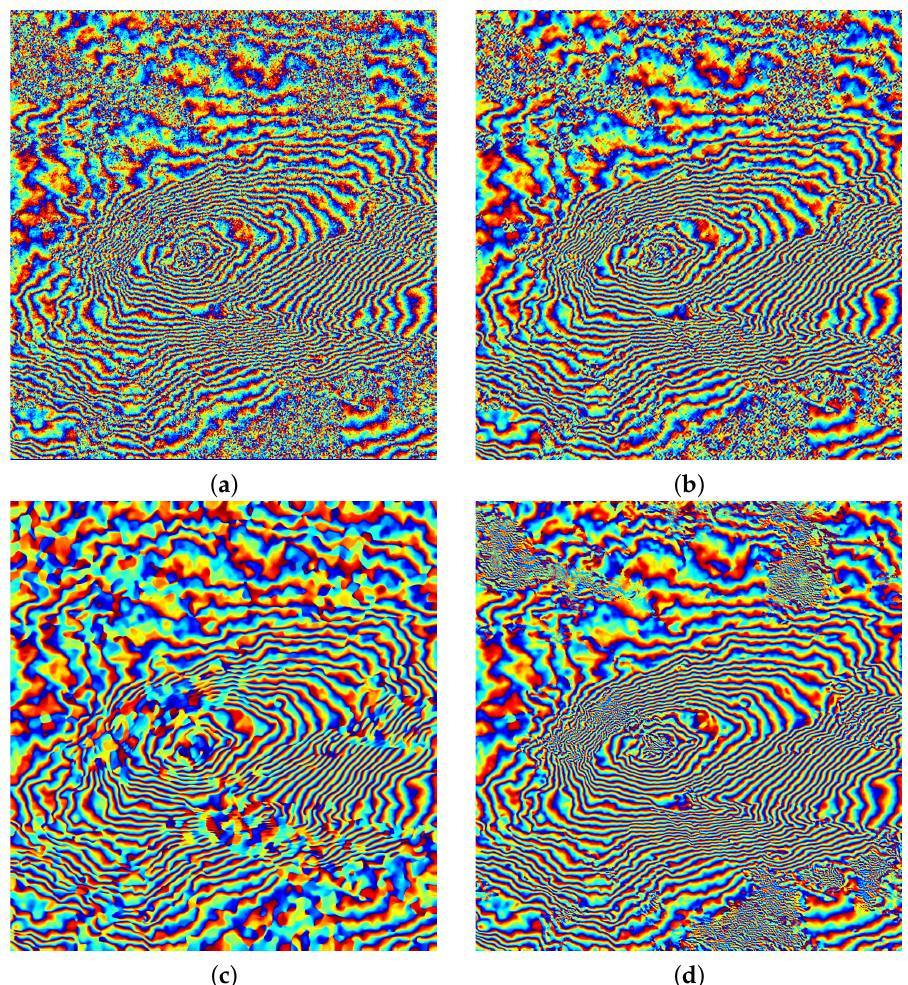
Figure 17. Filtered results of Figure 16 using four methods. ( a ) Lee filter. ( b ) Goldstein filter. ( c ) InSAR-BM3D filter. ( d ) Proposed